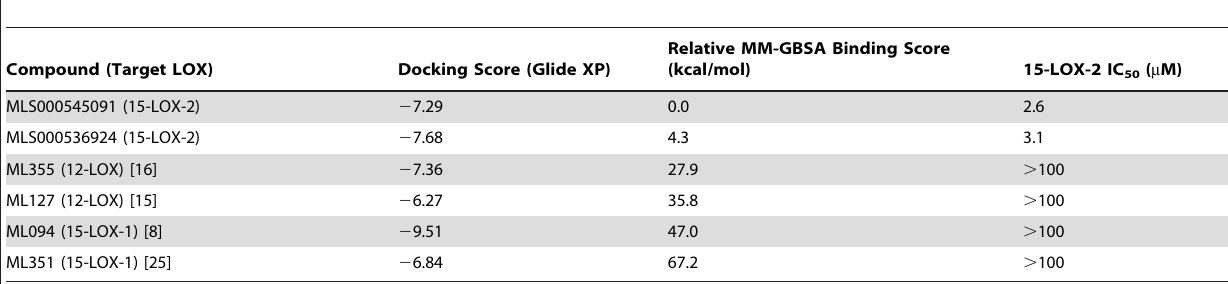
Table 3. The docking scores and relative binding energies of selective 15-LOX-2, 12-LOX and 15-LOX-1 inhibitors docked to the 15-LOX-2 crystal